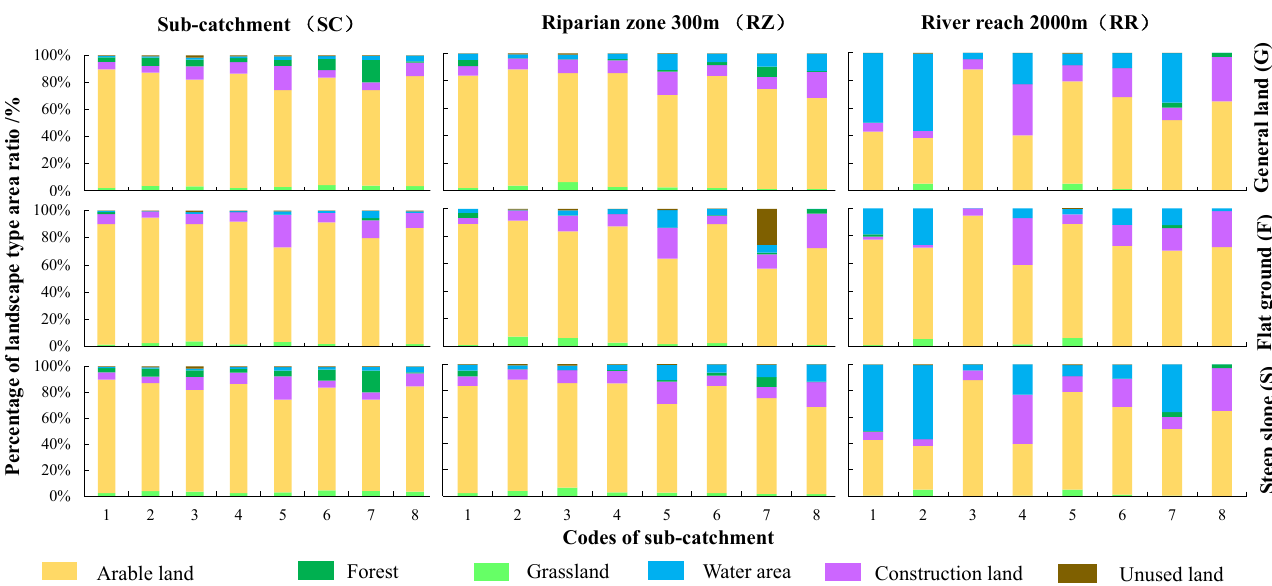
Figure 3. Statistical map of sloping landscape structure at different scales. Note: Sub-catchment (SC), Riparian zone (RZ), River reach (RR), General land (G), Flat ground (F), Steep slope (S).